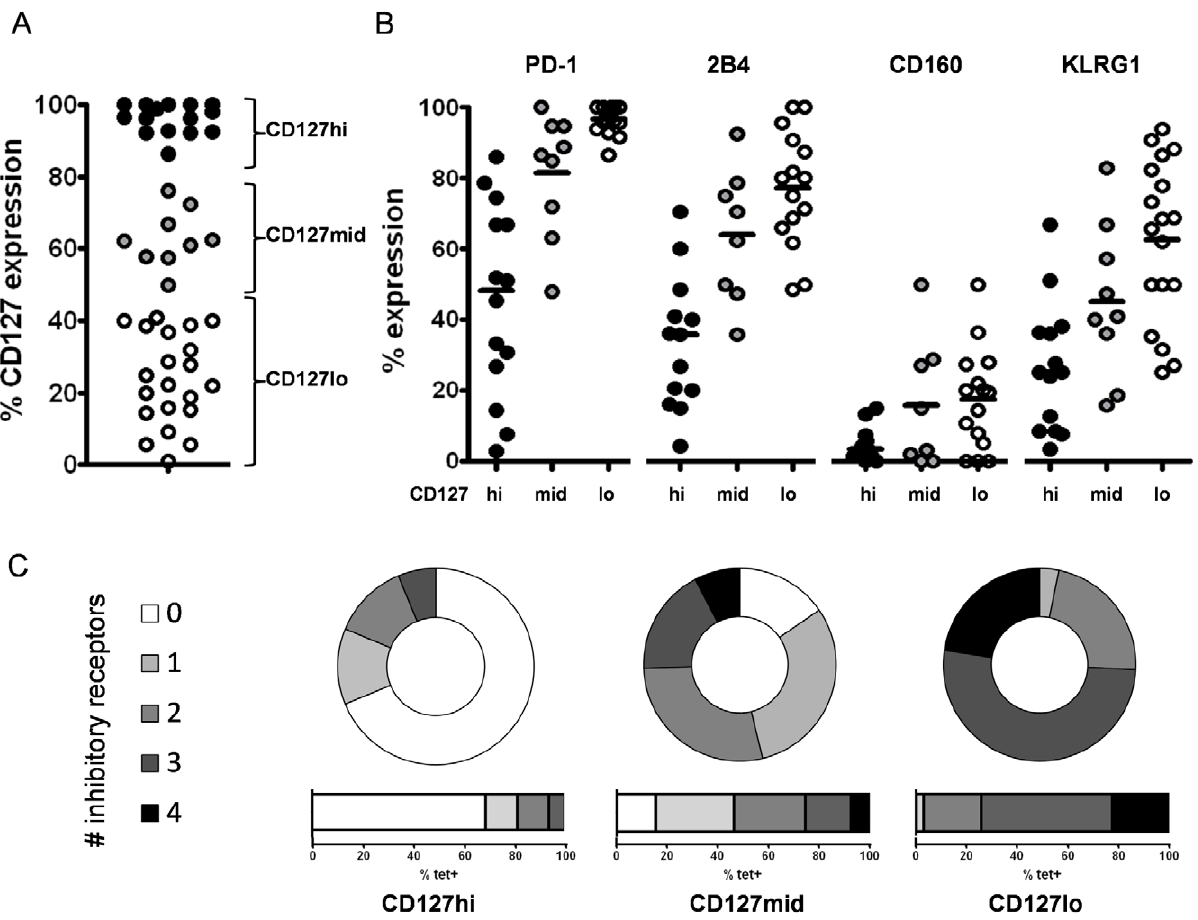
Figure 3. Inhibitory receptor expression is inversely linked to level of CD127 expression. (A) Three groups of HCV-specific CD8 + T cell responses can be distinguished by level of CD127 expression. High levels of CD127 expression ( . 80%) are displayed by black circles, intermediate levels of CD127 (50–80%) by grey circles and a low expression of CD127 ( , 50%) by white circles. (B) Expression of inhibitory receptors PD-1, 2B4, CD160 and KLRG1 is shown for CD127hi (black circles), CD127mid (grey circles) and CD127lo (white circles) HCV-specific CD8 + T cells. Significant differences of inhibitory receptor expression between the CD127 subgroups were observed for PD-1 expression (p , 0.0001), 2B4 expression (p , 0.0001), CD160 expression (p , 0.05) and KLRG1 expression (p , 0.0001). (C) Coexpression of inhibitory receptors on HCV-specific CD8 + T cells on a single-cell-level. Displayed is the frequency of HCV-specific CD8 + T cells within a given epitope expressing 0 (white), 1 (light grey), 2 (grey), 3 (dark grey) or 4 (black) inhibitory receptors. Representative diagrams are shown for a CD127hi epitope (pt. 4-NS3-1406), CD127mid epitope (pt. 26-NS3- 1406) and CD127lo epitope (pt. 4-NS5-2594). Coexpression of inhibitory receptors inversely correlates with CD127 expression.